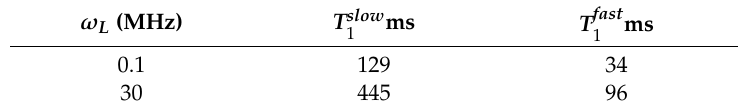
Table 1. Longitudinal relaxation times for the quartz sand sample added with Milli-Q grade water as